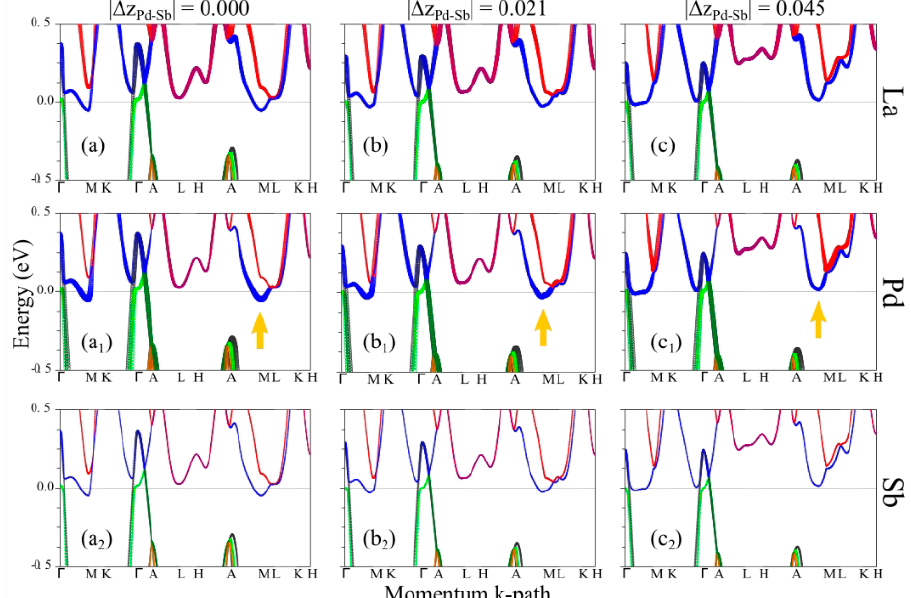
Figure 5. Fat band representation of the DFT electronic structure calculations for LaPdSb: panels ( a , a 1 , a 2 ) show the atomic contributions to the bands for the crystal with no puckering; panels ( b , b 1 , b 2 ) together with panels ( c , c 1 , c 2 ) show the atomic contributions to the bands for two distinct crystal structures with puckering as described in the text; the yellow arrow shows the dependence of the electron pocket Pd contribution at M point versus puckering.